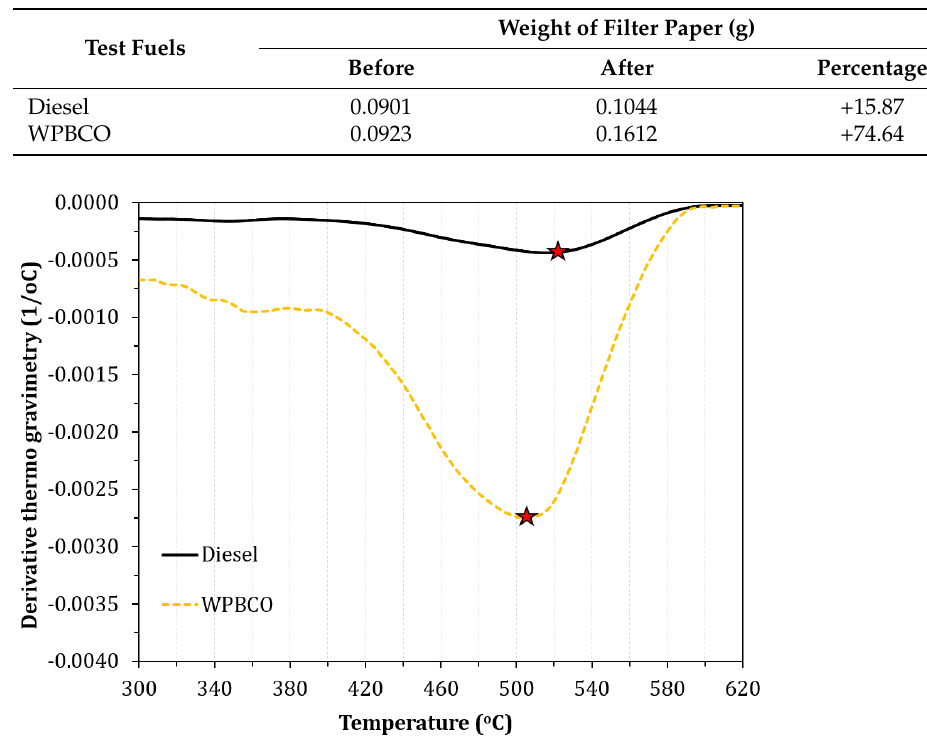
Figure 12. Variation in smoke emissions with respect to the engine load. Table 8. Difference of PM–loaded filter weight for diesel fuel and WPBCO.